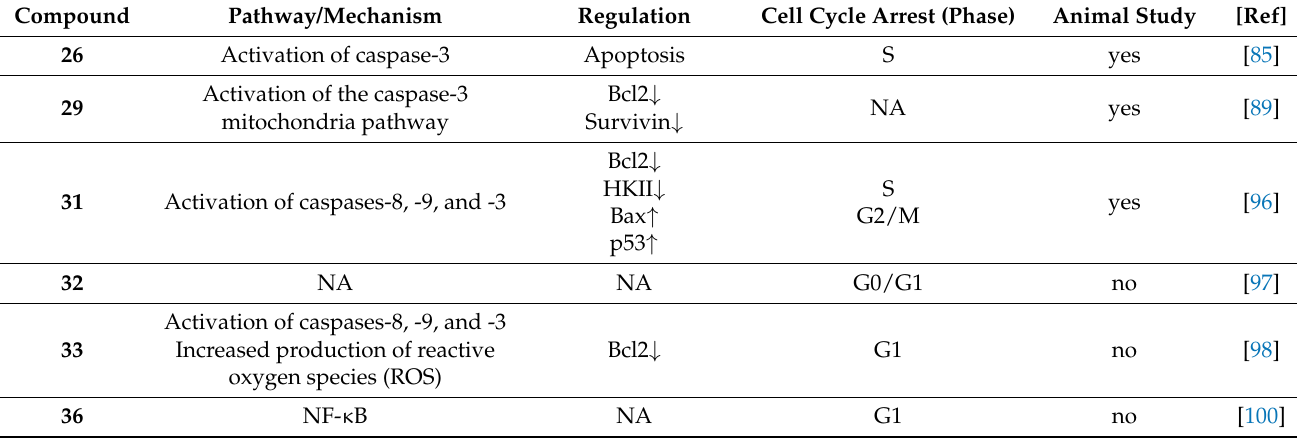
Table 5. Summarized information on UA analogs (C3 and C28